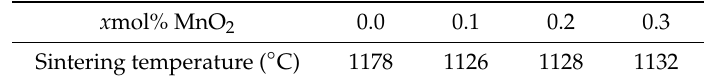
Table 1. Sintering temperature of KNLNT- x MnO 2 ( x = 0.0, 0.1, 0.2, 0.3)